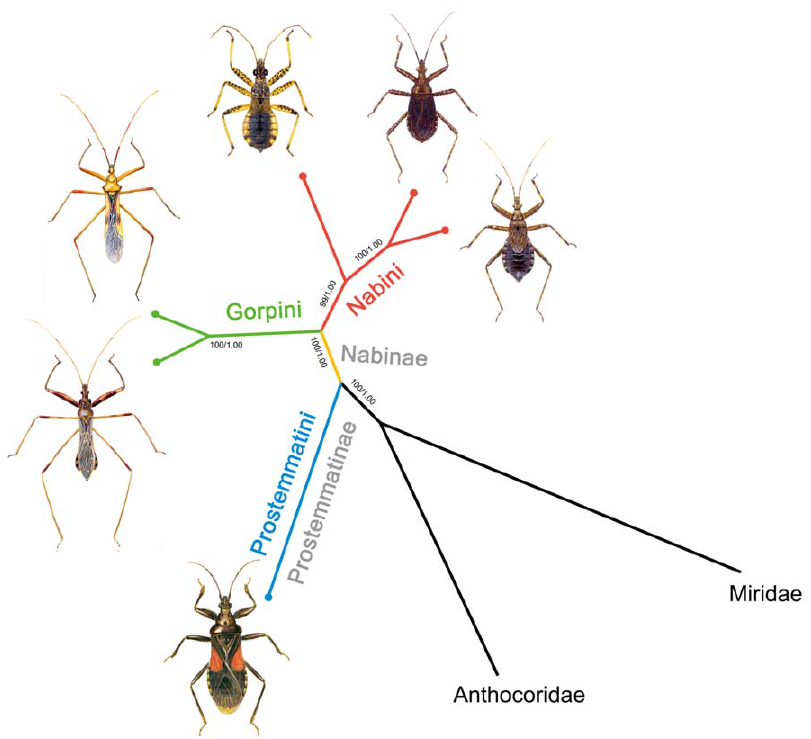
Figure 4. Molecular phylogenetic tree of six damsel bugs. Phylogenetic analysis was based on all mitochondrial genes (excluding trnI , trnQ and trnM ). The tree was rooted with two outgroup taxa ( O. niger and L. lineolaris ). Numbers close to the branching points are percentages of ML bootstrap support values (left) and Bayesian posterior probabilities (right).